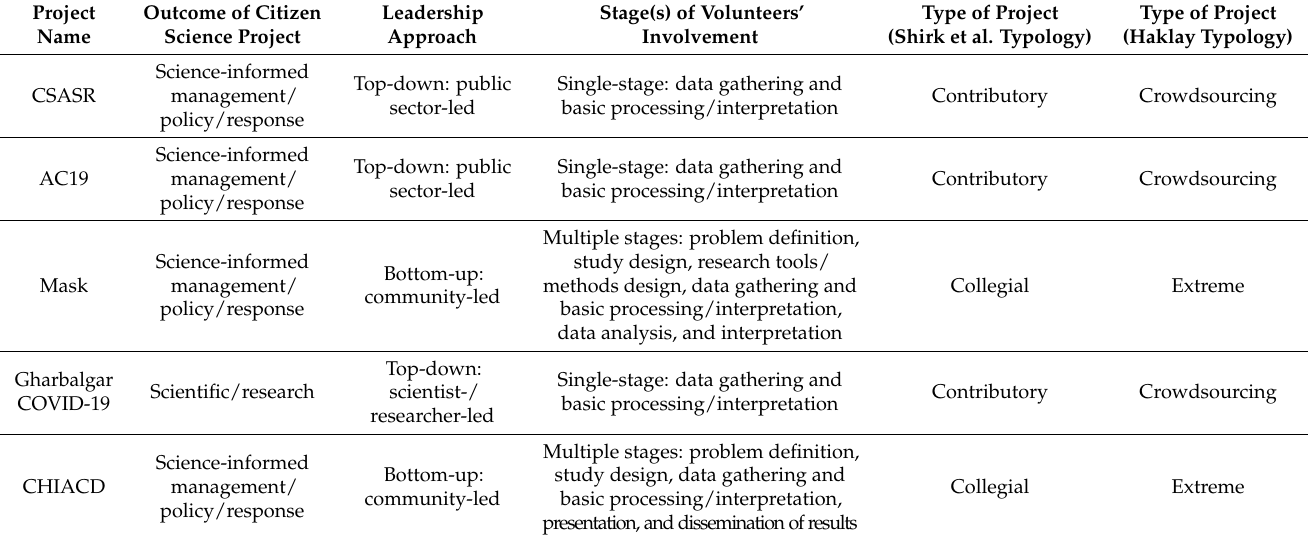
Table 2. Some of the main characteristics of five identified Iranian COVID-19-related online citizen science